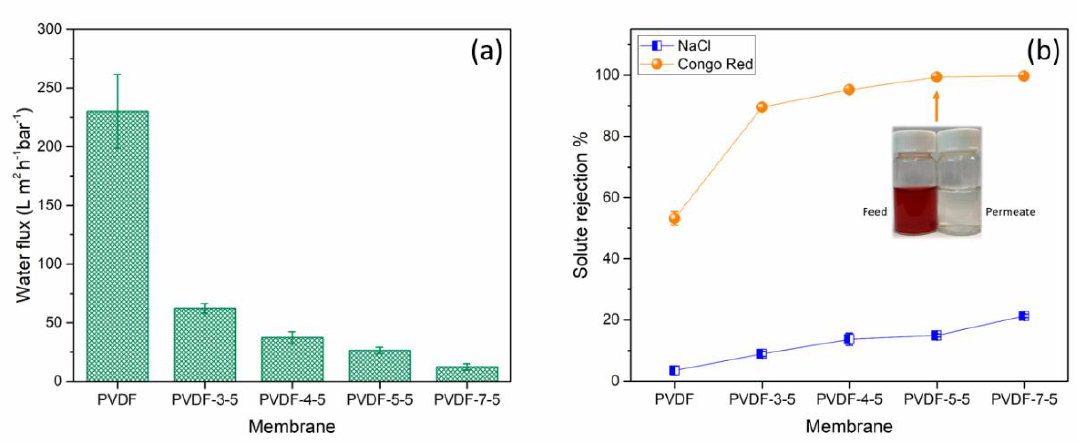
Figure 5. ( a ) The water flux and ( b ) Congo red and NaCl rejection of the membranes at pH 7.0. The error bar results were obtained from at least three different samples.